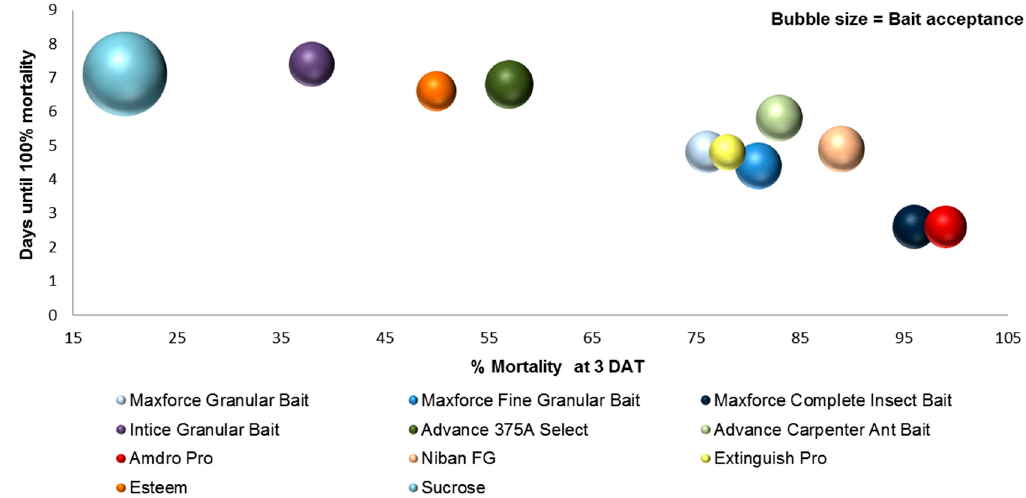
Figure 6. Laboratory assay results for bait performance criteria of acceptance, days until 100% mortality, and percent mortality at 3 DAT for commercially available granular ant baits combined into a single graph to allow direct comparisons. Baits indicated by bubbles in lower, right quadrant and with largest diameter are those with highest mortality at 3 DAT, fewest days to 100% mortality, and highest acceptance. Sucrose control is blue, top left corner.